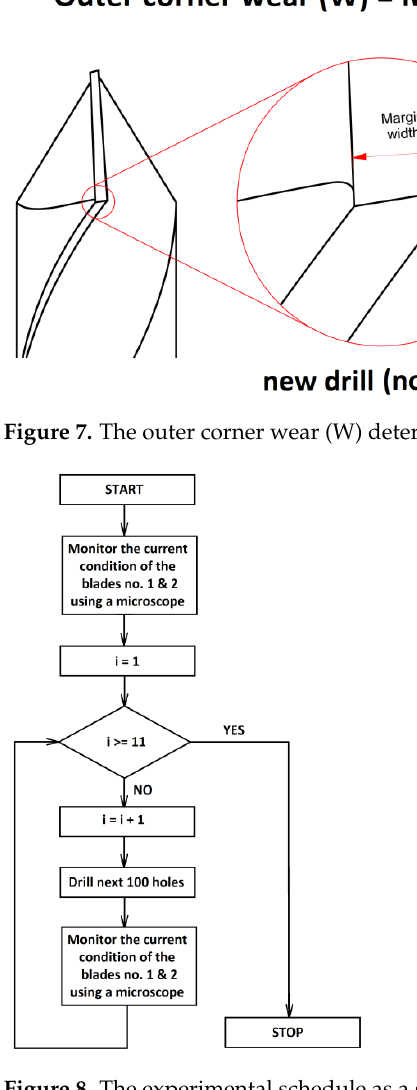
Figure 7. The outer corner wear (W) determination.